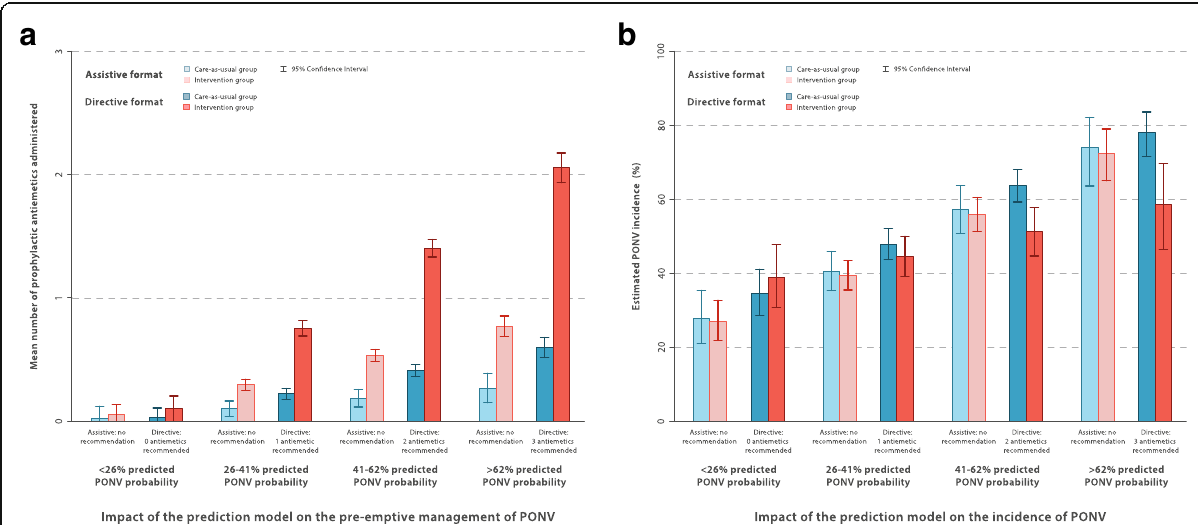
Fig. 2 Graphical representation of the mixed effects regression analysis on the pooled dataset of the two impact studies. In both studies, a prediction model for postoperative nausea and vomiting (PONV) was implemented (red colors) and compared to care-as-usual (blue colors). In one study, the probabilities of the model were simply presented to physicians who implemented without a recommendation (i.e. an assistive format; less saturated colors). The other study also included an actionable recommendation (i.e. a directive format; more saturated colors). Both studies compared the impact on the physicians ’ administration of antiemetic prophylaxis ( a ) and on the incidence of PONV ( b ). The bars and their 95% confidence intervals (CI) represent the fixed effects of the mixed effects regression analyses. The mixed effects models included fixed effects for the following variables: study, allocation group, predicted probability of PONV, and all interaction term between these variables. Because of the similarity of the results, the bars were calculated from the unadjusted analysis after multiple imputations. The 95% CIs were calculated from the covariance matrix for the variable study, allocation group, predicted probability, and their interaction terms. Further methodologic information and the numerical results of the regression models are available in Additional file